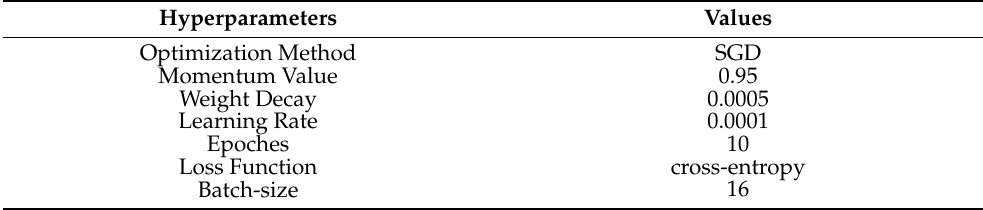
Table 4. Hyperparameter